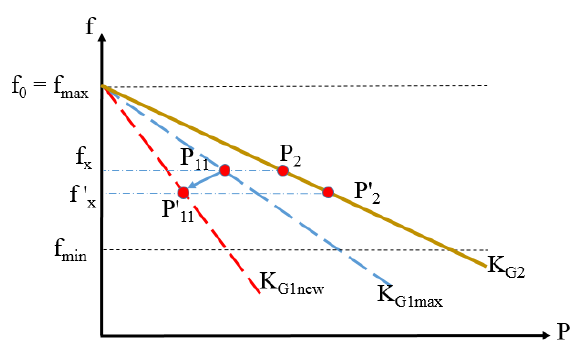
Figure 3. Power sharing with new droop control method among two generating units.